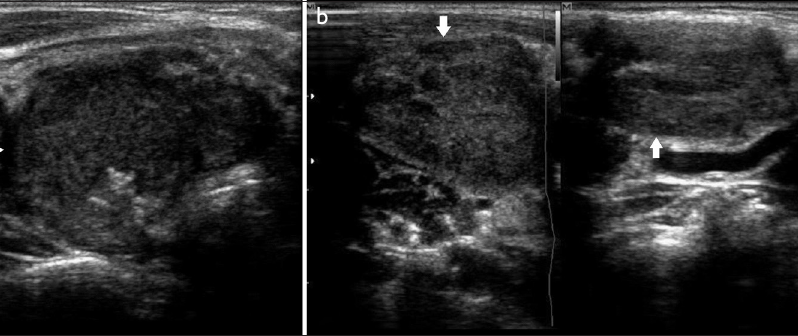
Figure 2. a, b. Neck ultrasonography. (a) Lymph nodes greater than 2 cm in the right lateral neck. (b) A 5.2 × 3 cm massive thyroid nodule with irregular borders covering a large part of the right lobe.